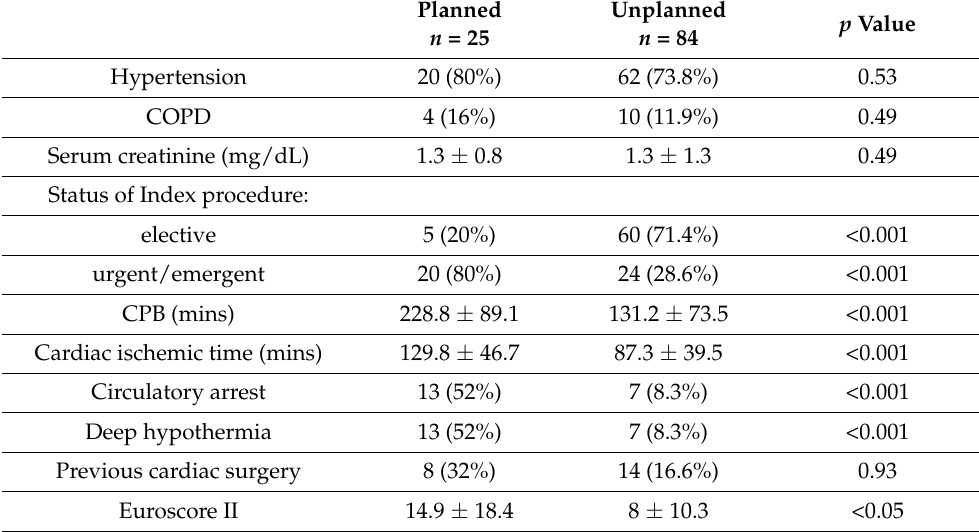
Table 8. Re-explorations in the ICU setting: Outcomes.